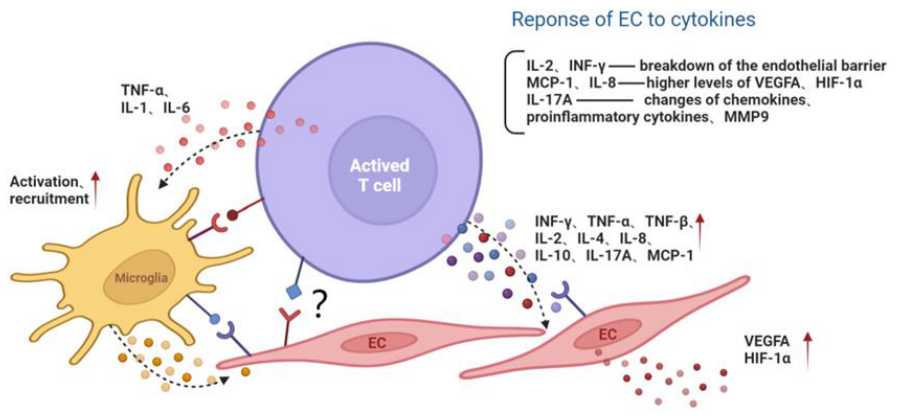
Figure 2. The interaction among activated T lymphocyte, endothelial cell and microglia. Activated T cells secrete cytokines or directly contact microglia and the EC, aggravating the inflammatory microenvironment and endothelial dysfunction. Red arrows represent the upregulation of gene expression. Black dotted arrows stand for cellular interaction through paracrine pathway. EC, endothelial cell; MMP9, matrix metalloproteinase 9; MCP-1, monocyte chemoattractant protein-1; INF, interferon; TNF, tumor necrosis factor; IL, interleukin; VEGFA, vascular endothelial growth factor A; HIF-1 α , hypoxia inducible factor-1 α .